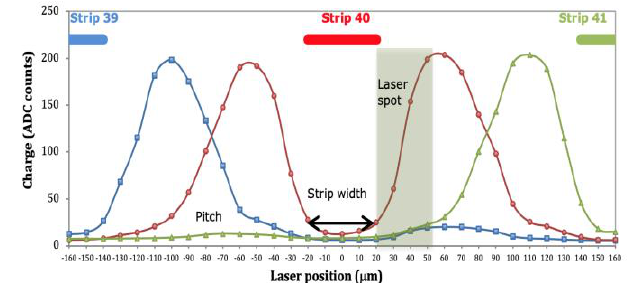
Fig. 6. Signal deposition by the laser bean in three consecutive strips obtained by moving the laser in 10μm steps perpendicular to the strips. The signal recorded by strip 39 is represented in blue, in red the signal in strip 40 and in green the signal in strips